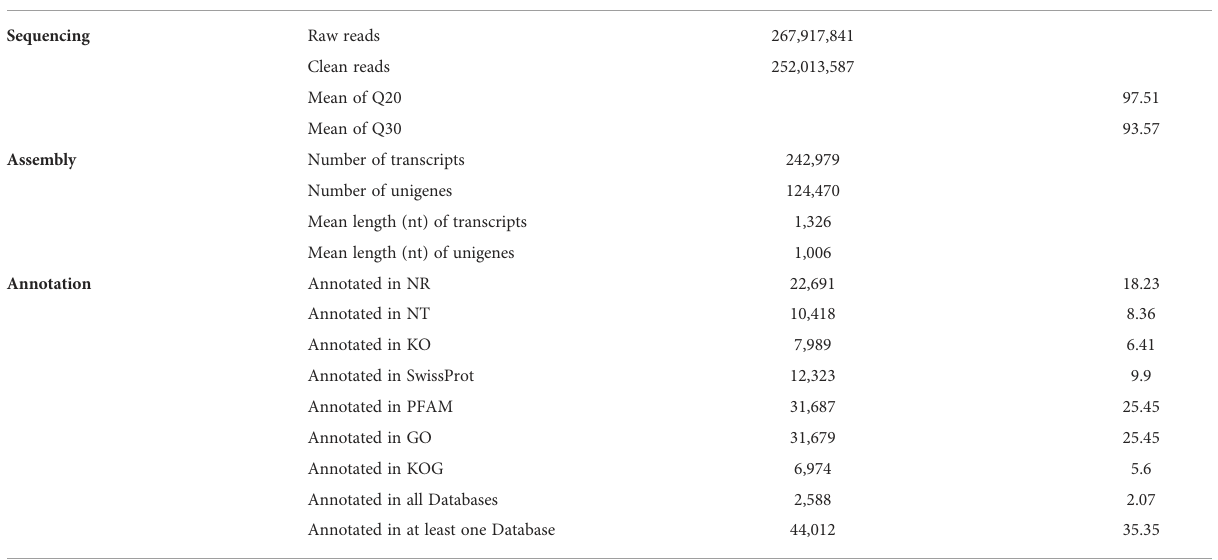
TABLE 1 Summary of sequence analysis in S. paramamosain thoracic ganglia.